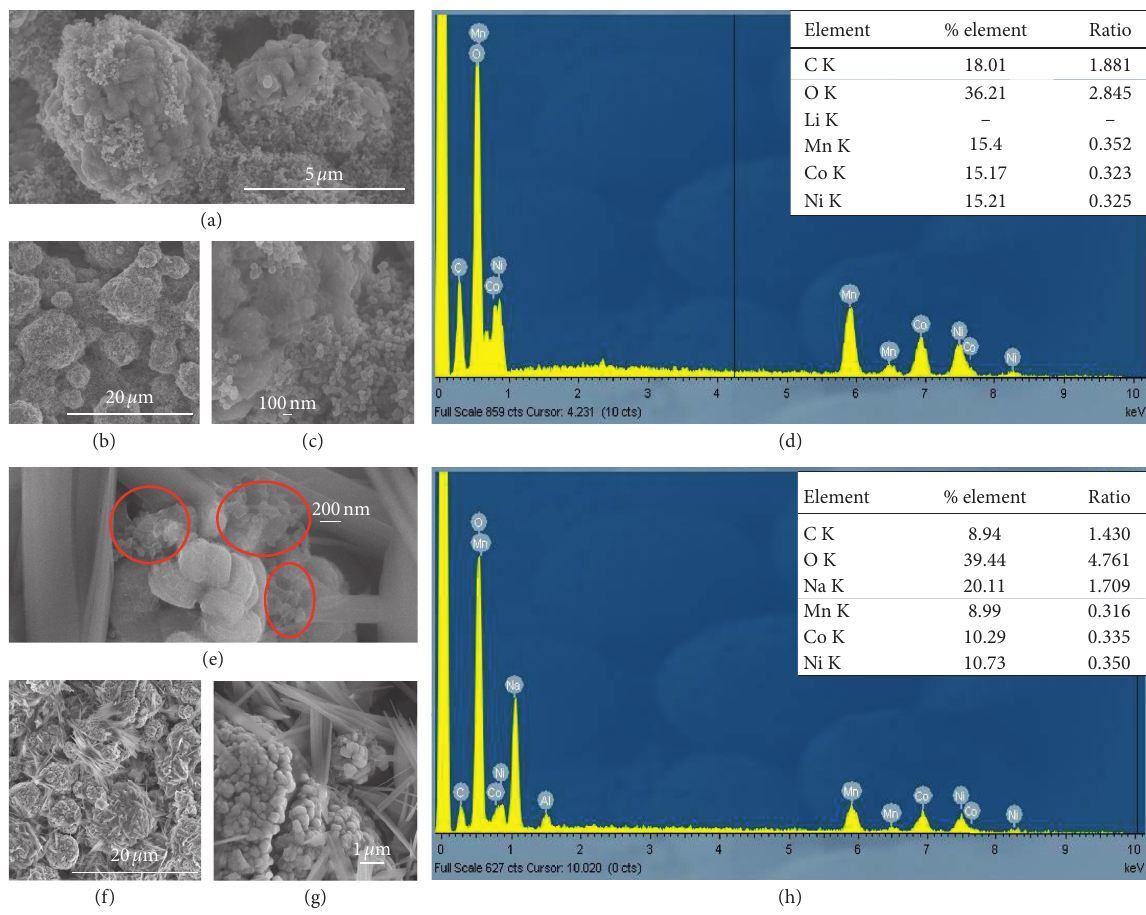
Figure 5: SEM images of the pristine electrode LiNMC (a-c) and the EDX spectrum (d). SEM images of the sodiated Na in sodium half-cell (e-g) and the EDX spectrum (h). EDX results for elements percentage were put inside the corresponding EDX